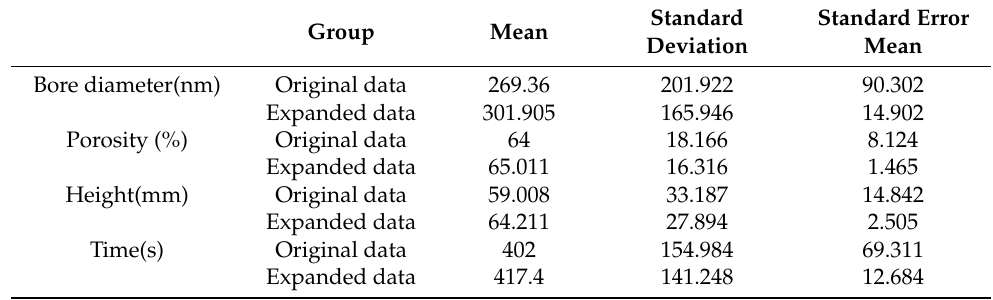
Table 2. Group statistics.